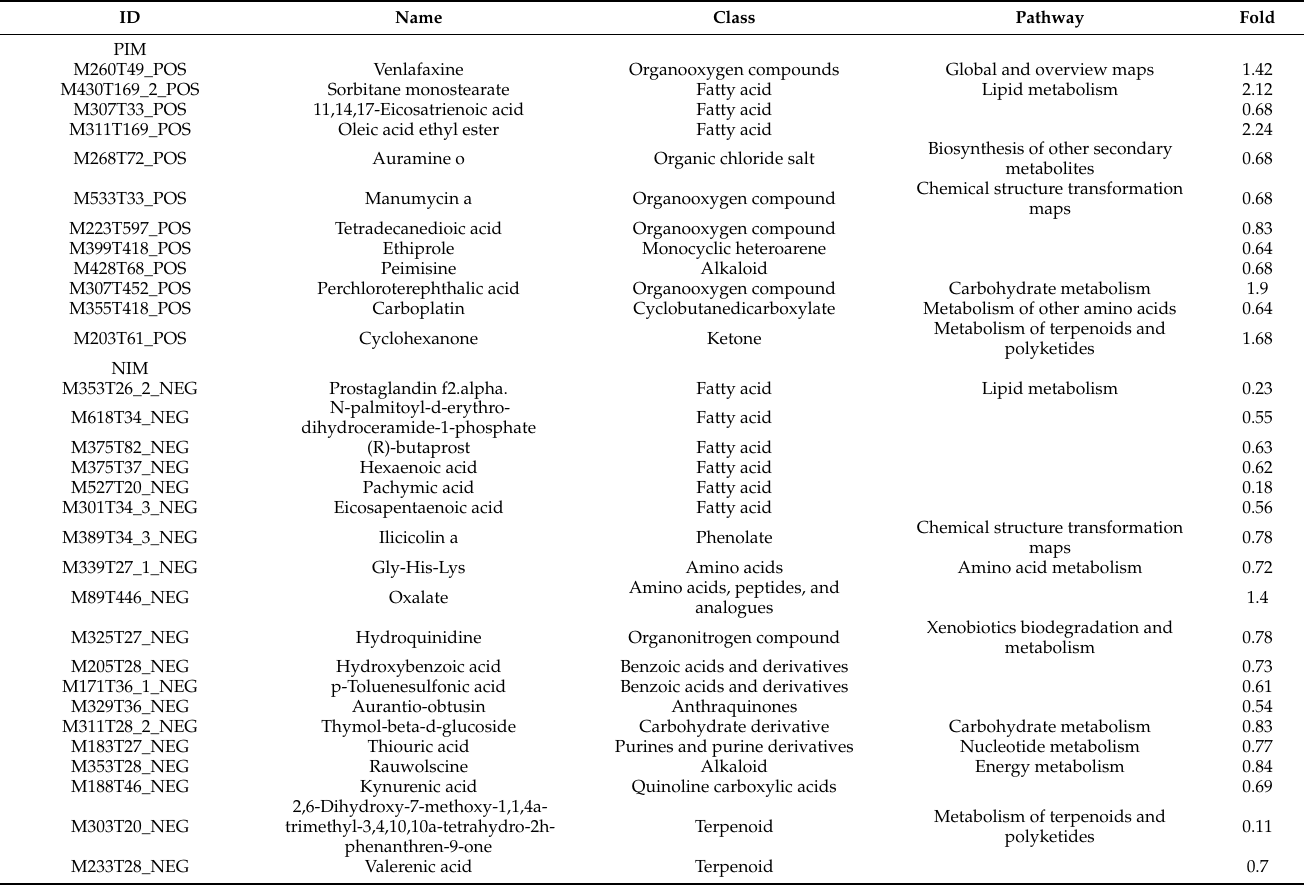
Table 3. KEGG pathway classes of DEMs in RS_vs_RSSI